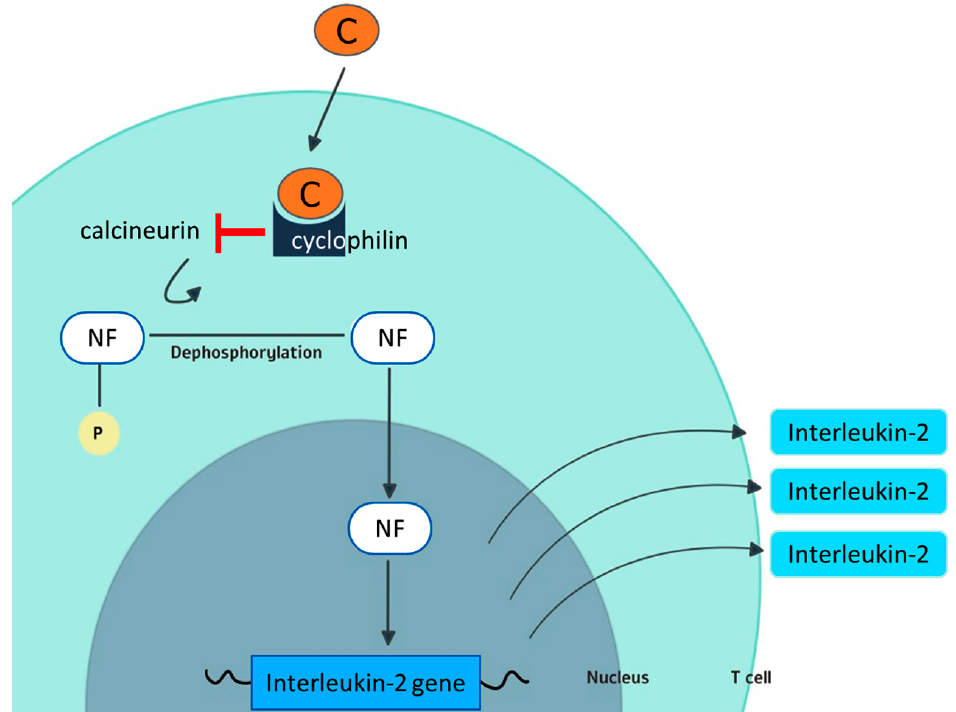
Figure 1. Mechanism of action of cyclosporine. In the cytoplasm of T cells, cyclosporine (C) forms a complex with cyclophilin. The cyclosporine–cyclophilin complex interferes with the phosphatase activity of the enzyme calcineurin. As a consequence, calcineurin cannot dephosporylate the nuclear factor (NF) that limits IL-2 production by T cells and its full activation. Cyclophilin is also believed to be one of the targets for the antiviral activity of